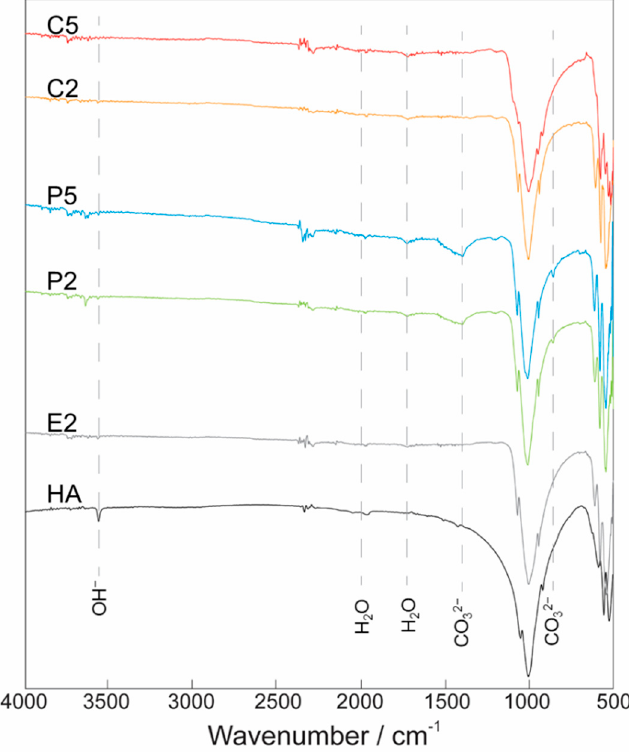
Figure 3. FTIR spectra for Ca-deficient (C2 and C5) and P-deficient (P2 and P5) AgHAs compared to E2 and pure HA heat-treated at 1100 °C. Y-axis: arbitrary unit.